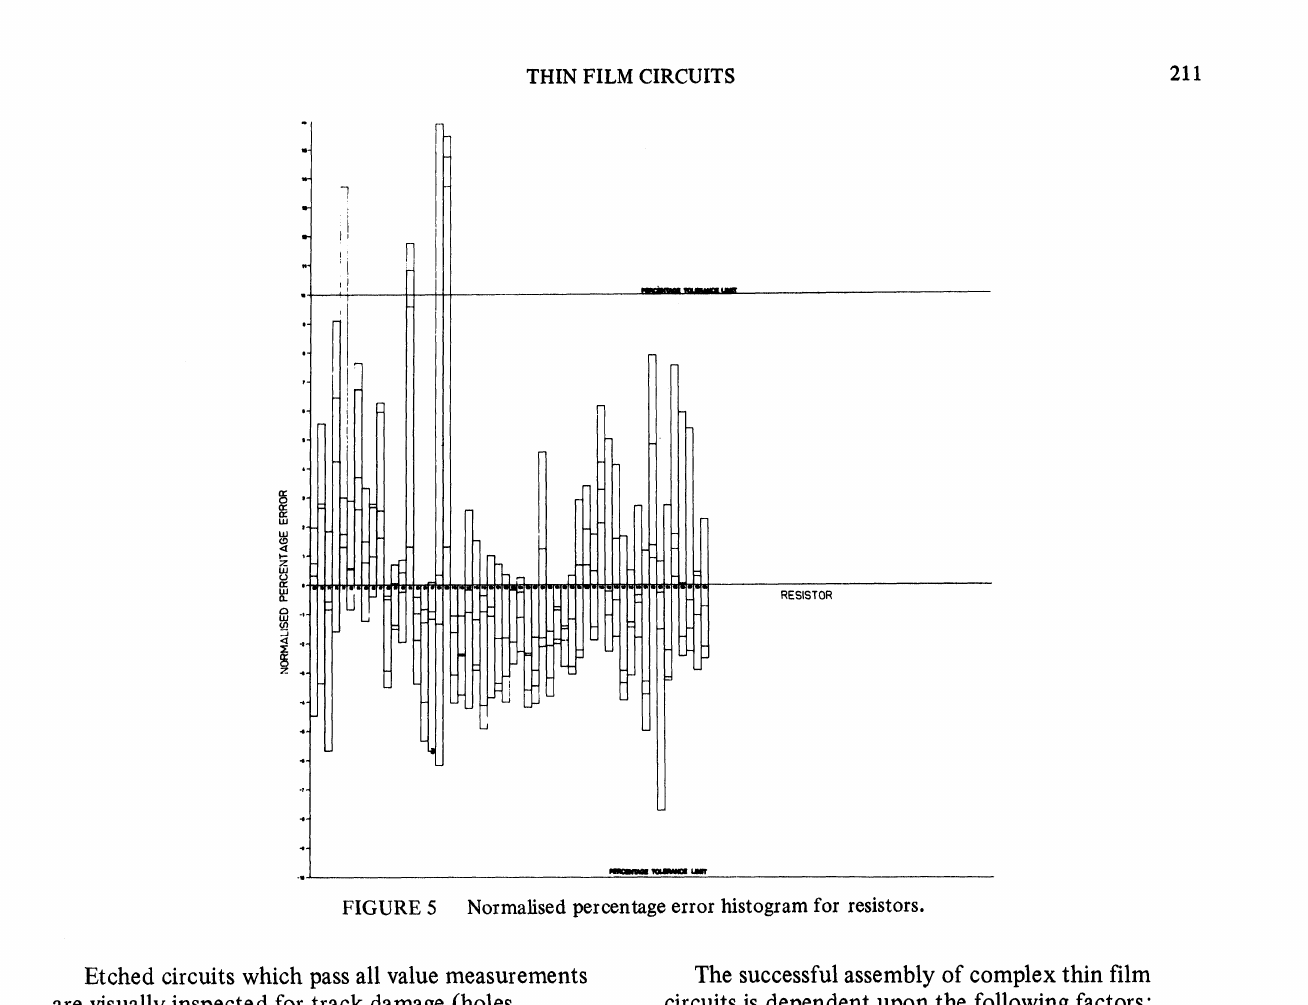
FIGURE 5 Normalised percentage error histogram for